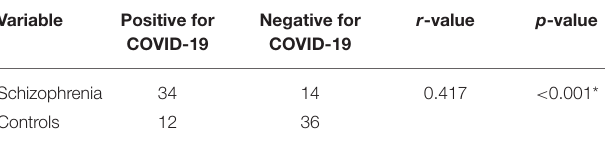
TABLE 4 | Correlation of schizophrenia and non-schizophrenia with